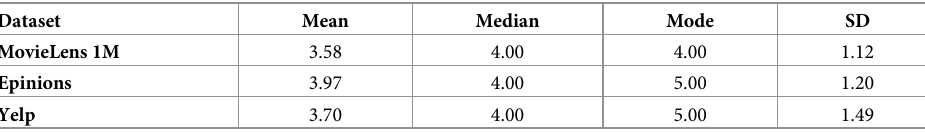
Table 4. Statistic of each